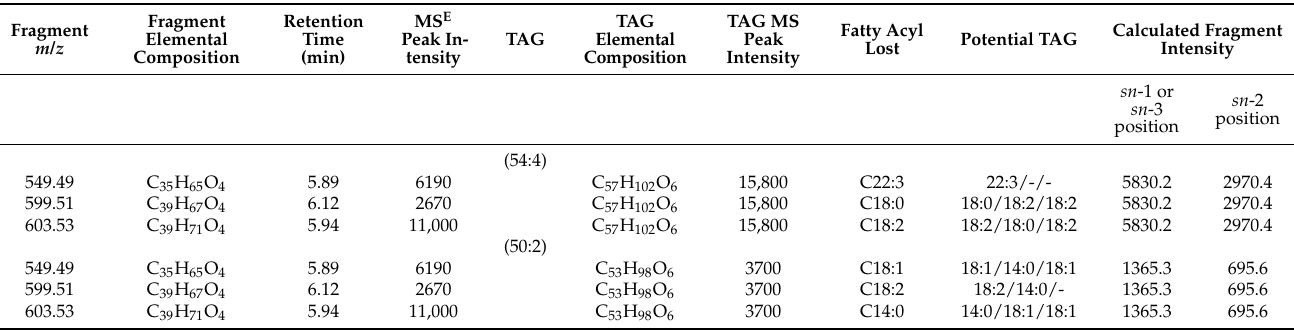
Table 1. Example of fragment ascription for composition determination of two partially co-eluting TAGs.